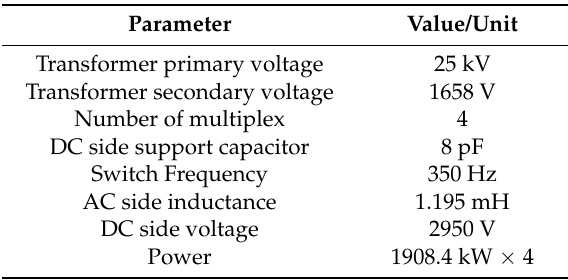
Table 1. Simulation parameters of four quadrant converter.